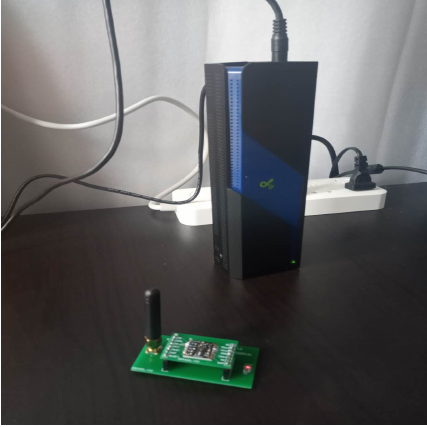
Figure 5. Experimental scene graph having the charger and wireless sensor